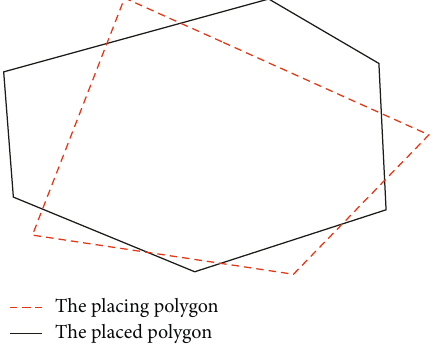
Figure 3: Situation of edge